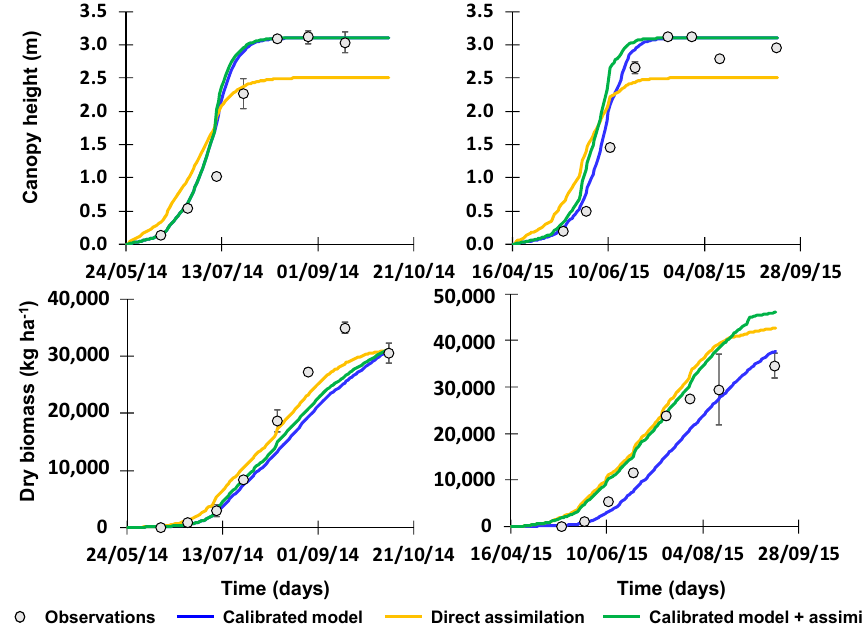
Figure 6. Measured and simulated canopy height ( top ) and aboveground dry biomass ( bottom ) during 2014 ( left ) and 2015 ( right ) crop seasons. Vertical bars correspond to the standard deviation of measured data.